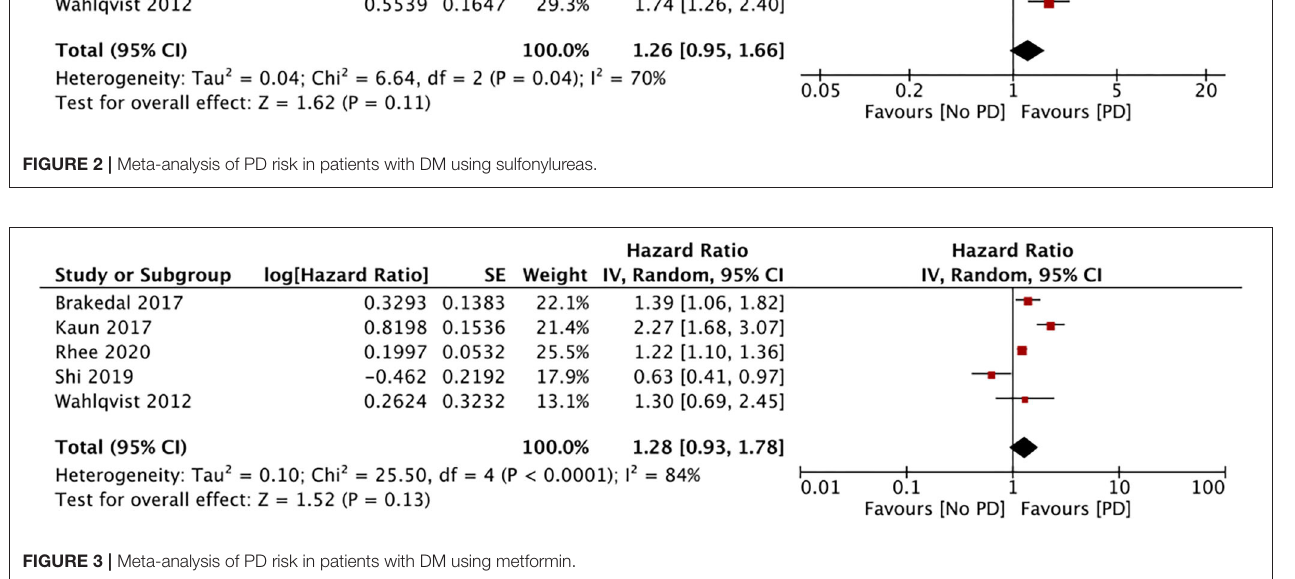
FIGURE 3 | Meta-analysis of PD risk in patients with DM using metformin.